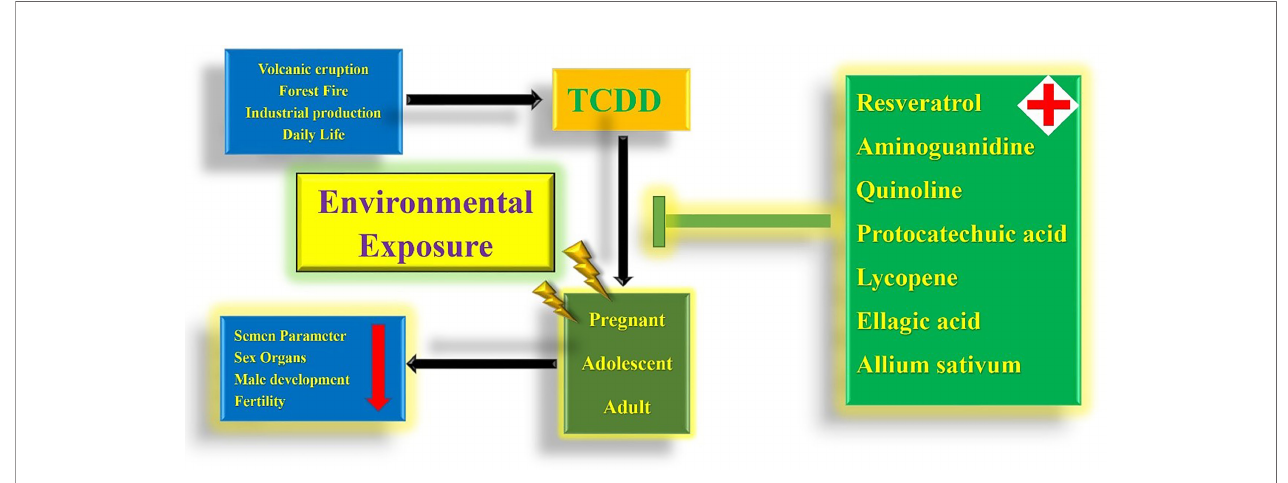
FIGURE 3 | Holistic view of TCDD environmental exposure and